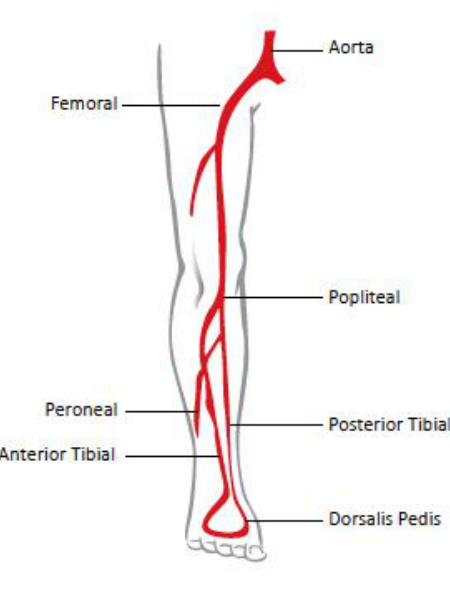
Figure 8. Sites for palpating foot